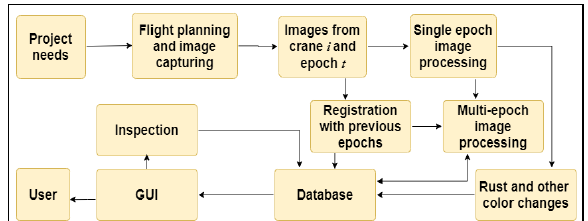
Figure 1 . The overall concept of the project